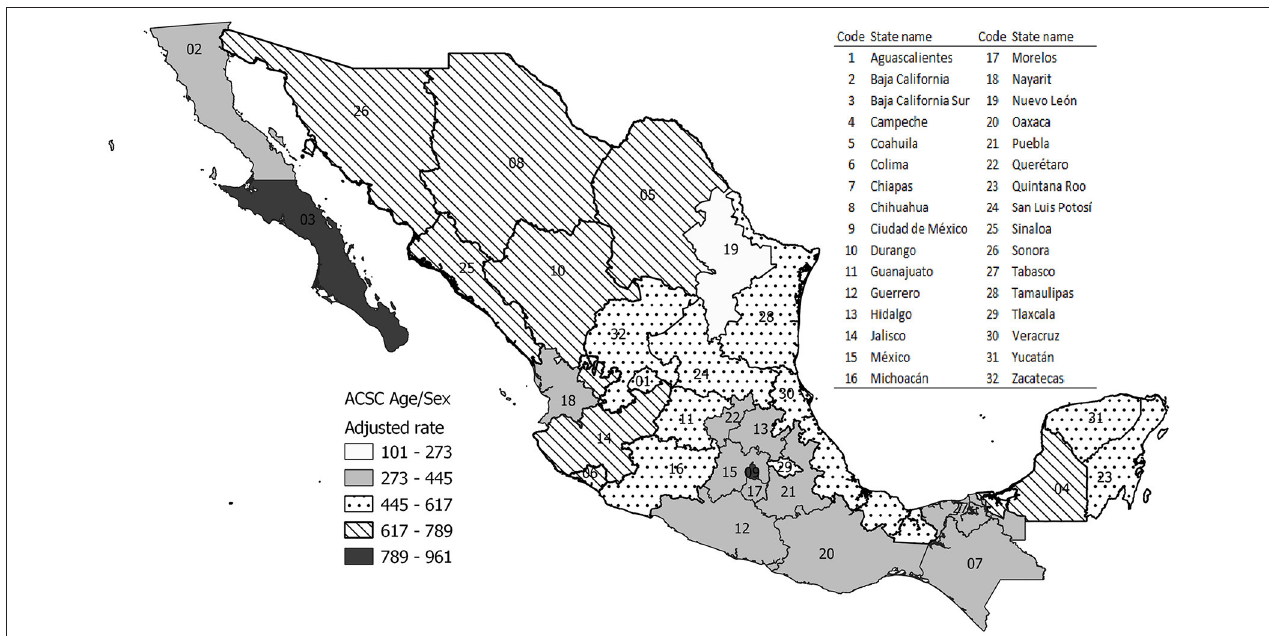
FIGURE 1 | Geographic pattern of the AH rates by ACSC in